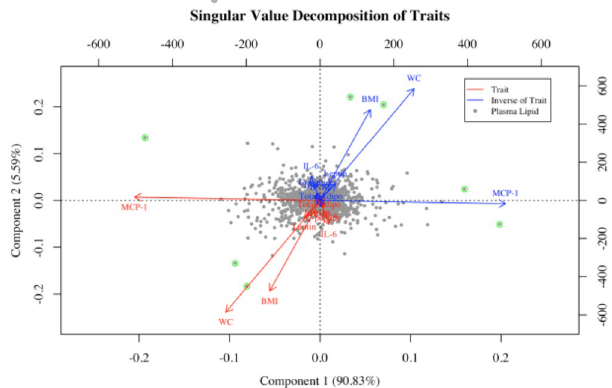
Figure 3. Singular value decomposition modeled on the 1,745 regression beta coefficients from plasma lipids in age and smoking regression for each respective parameter. ( ) represent the plasma lipid loading score into vectors 1 and 2. Plasma lipids are highlighted if radius > 0.15. Parameters are listed in red text with red arrows and the inverse of the parameters are listed in blue text with blue arrows. The score of MCP-1 in vector 1 is scaled by a factor 25 (i.e., original score > 12,000). Body mass index (BMI), waist circumference (WC), tumor necrosis factor-alpha (TNF- α ), interferon gamma-induced protein-10 (IP-10), interleukin-6 (IL-6), monocyte chemoattractant protein-1 (MCP-1).